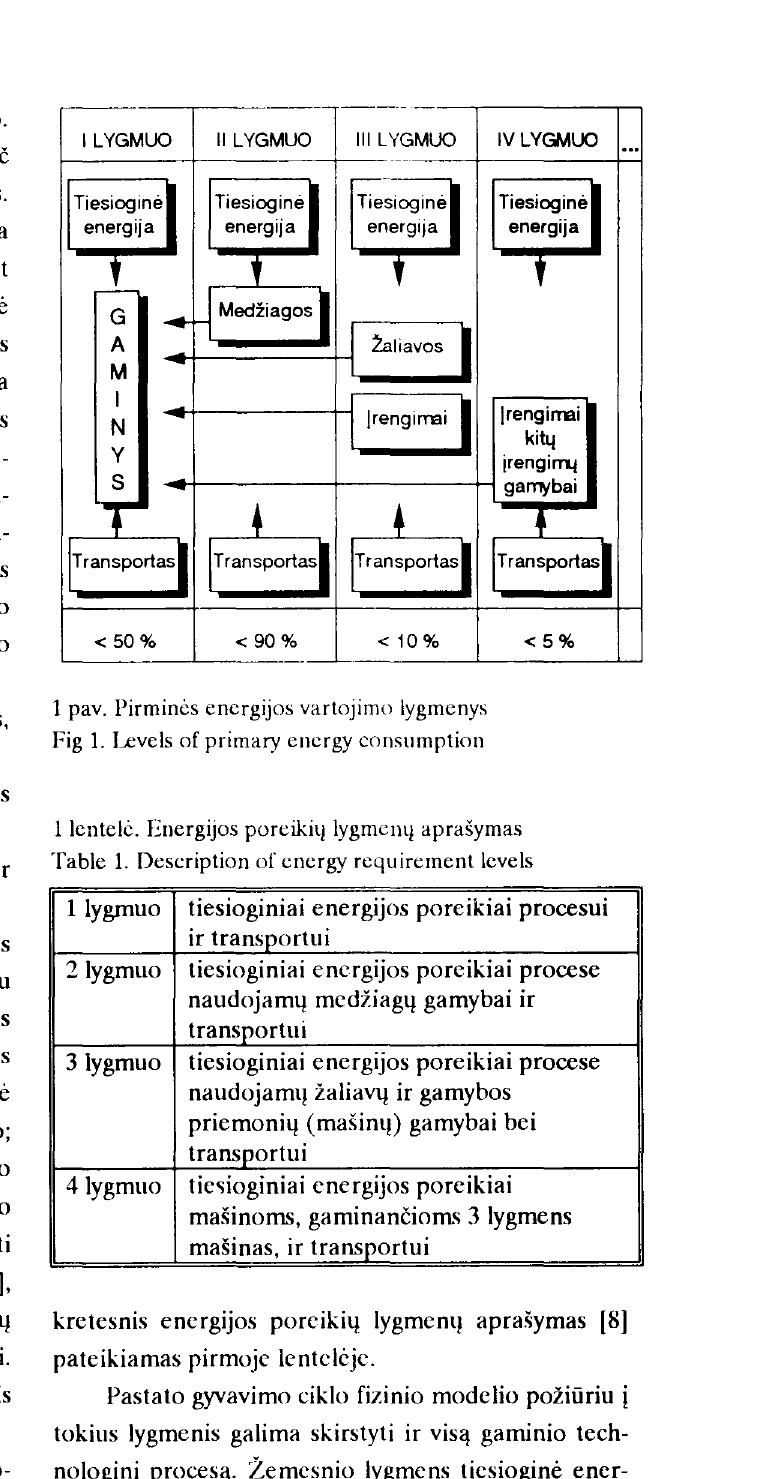
Fig 1. Levels of primary energy consumption